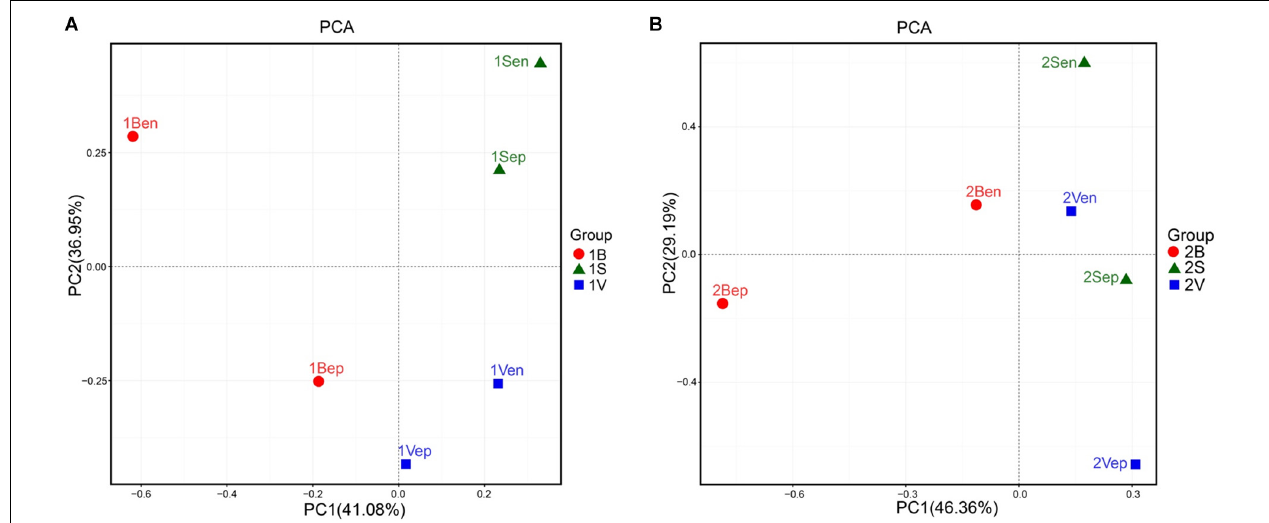
FIGURE 10 | Principal Component Analysis (PCA) of the bacterial communities from blade, stalk, and vesicle of S. horneri based on Euclidean distance at genus level. (A) Brown S. horneri . (B) Yellow S. horneri